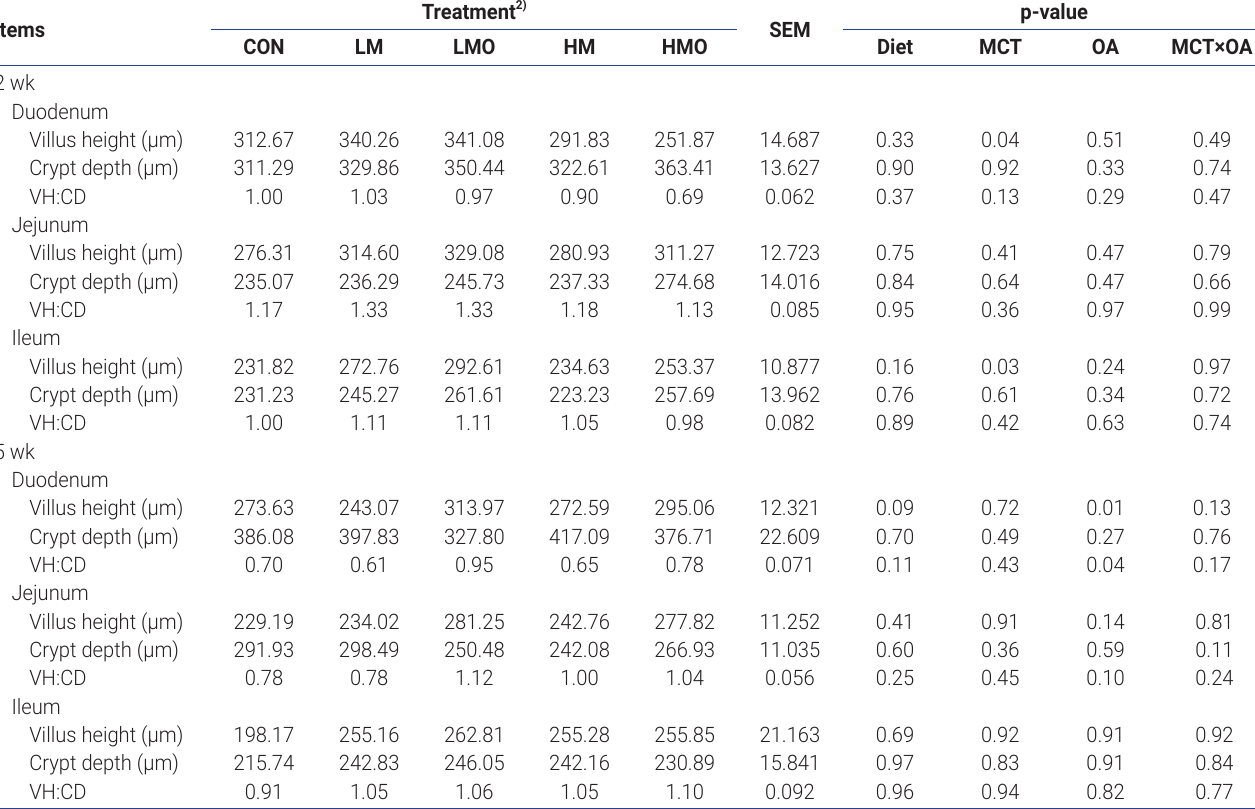
Table 6. Effects of medium chain triglycerides and organic acids on histomorphology of small intestine in weaning pigs 1)